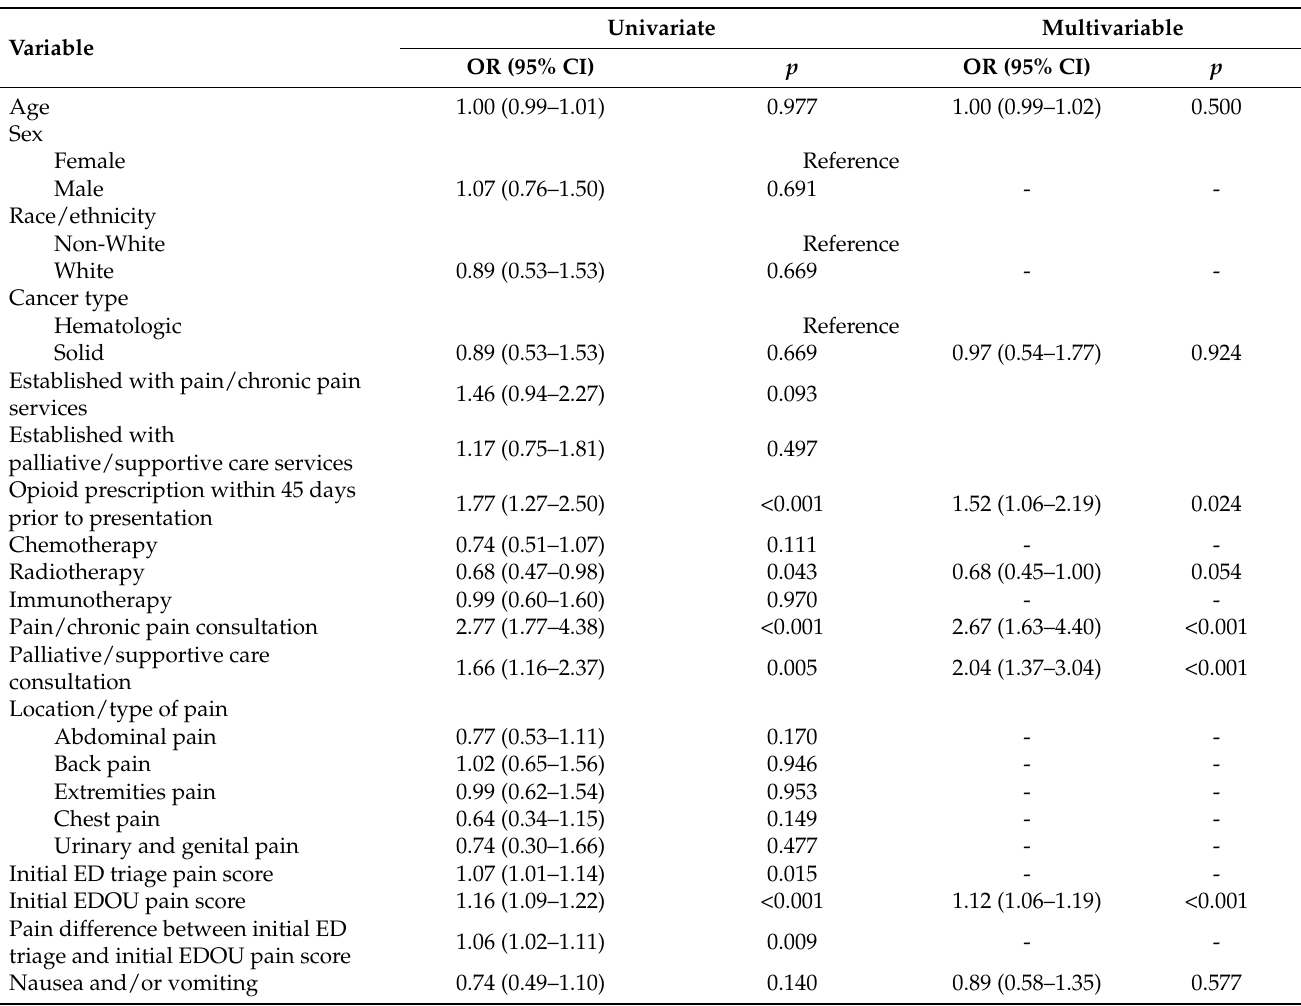
Table 5. Univariate and multivariable logistic regression analyses of the association of clinical variables with hospital admission after emergency department observation unit